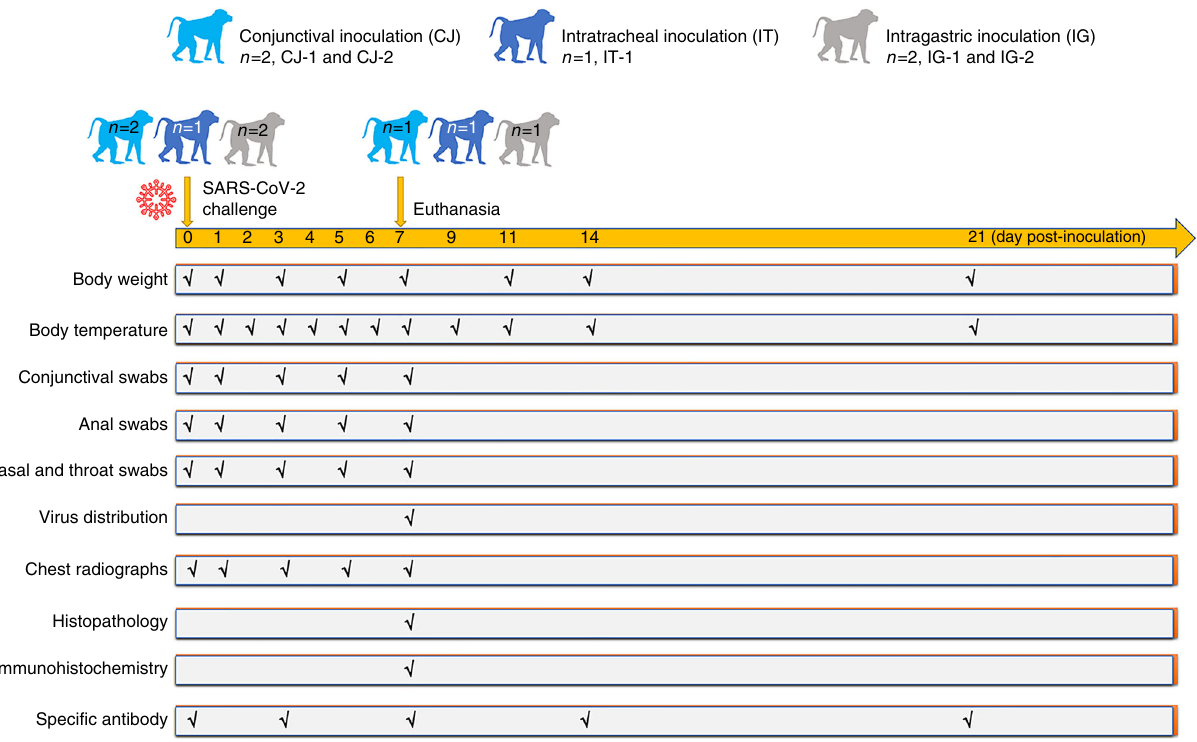
Fig. 1 Graphical outline of the experimental design and sample collection. Five male rhesus macaques ( Macaca mulatta ) were inoculated with 10 6 TCID 50 /mL SARS-CoV-2. Two rhesus macaques were inoculated via the ocular conjunctival route and named CJ-1 and CJ-2, one was inoculated via the intratracheal route and named IT-1, and two were inoculated via the intragastric route in sequence and named IG-1 and IG-2. The macaques were observed for clinical signs (body weight and temperature were tested as shown). On 0, 1, 3, 5, and 7 dpi, conjunctival, nasal, throat, and anal swabs were collected. CJ-1, IT-1, and IG-1 were euthanized and necropsied at 7 dpi. Tissues were collected to analyse the viral loads and titres. Serum was collected from all animals at 0 and 7 dpi and from CJ-2 and IG-2 at 14 and 21 dpi to examine the speci fi c IgG antibodies against SARS-CoV-2